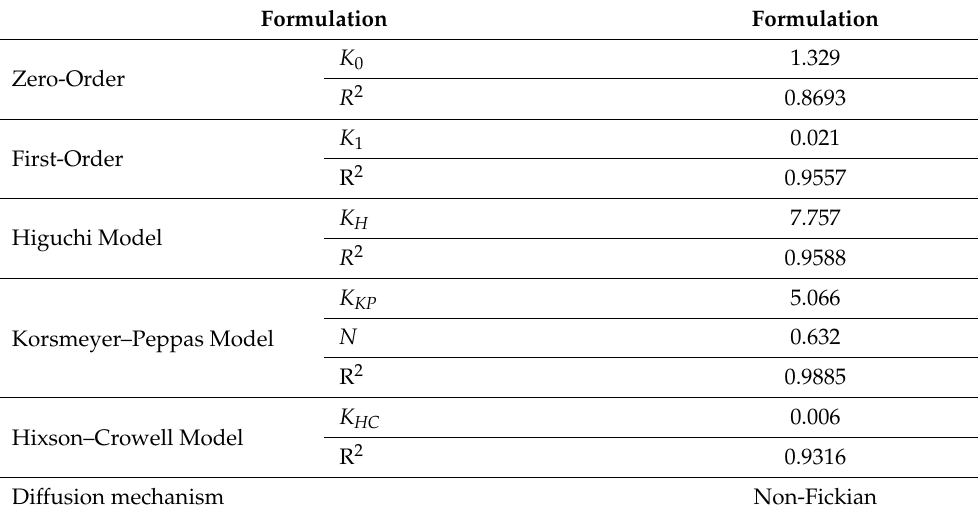
Table 1. Drug release kinetic models. Formulation